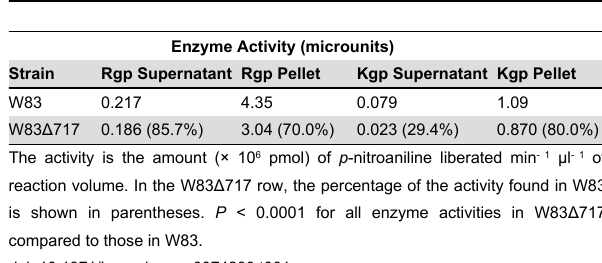
Table 1. Gingipain activity associated with whole cells and culture supernatants of deletion mutant W83Δ717 vs. those of